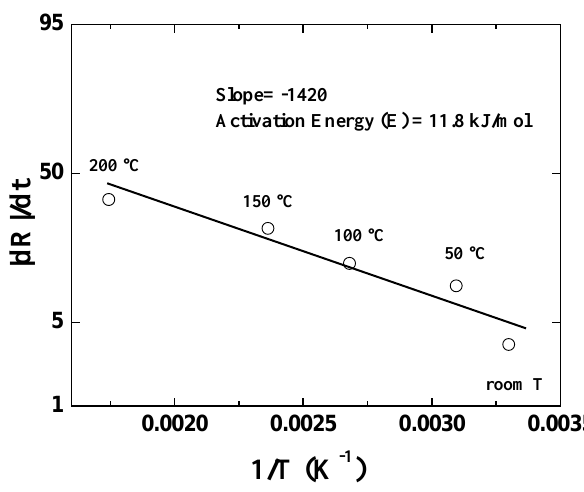
Figure 13 . Arrhenius plot of rate of resistance change after exposure to 500 ppm H